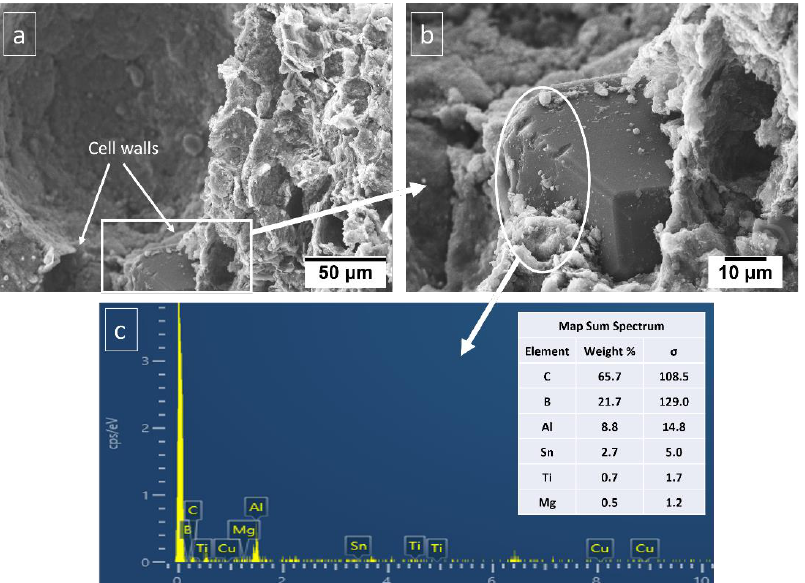
Figure 3. SEM images of ( a ) cell wall, ( b ) diamond particle in the cell wall and ( c ) EDS of material adhered to diamond particle in sintered porous Al composite.